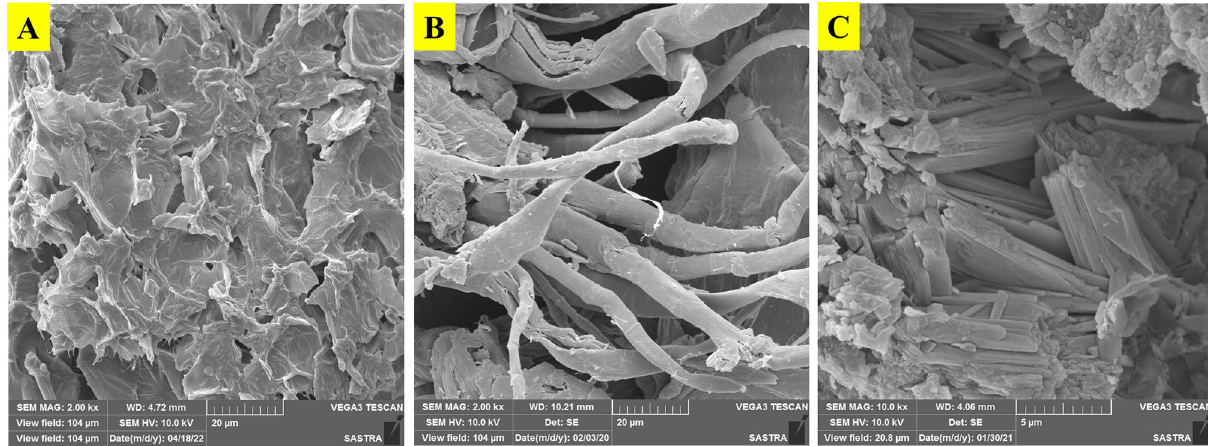
Figure 4. SEM images of ( A ) Pj pods ( B ) cellulose ( C )